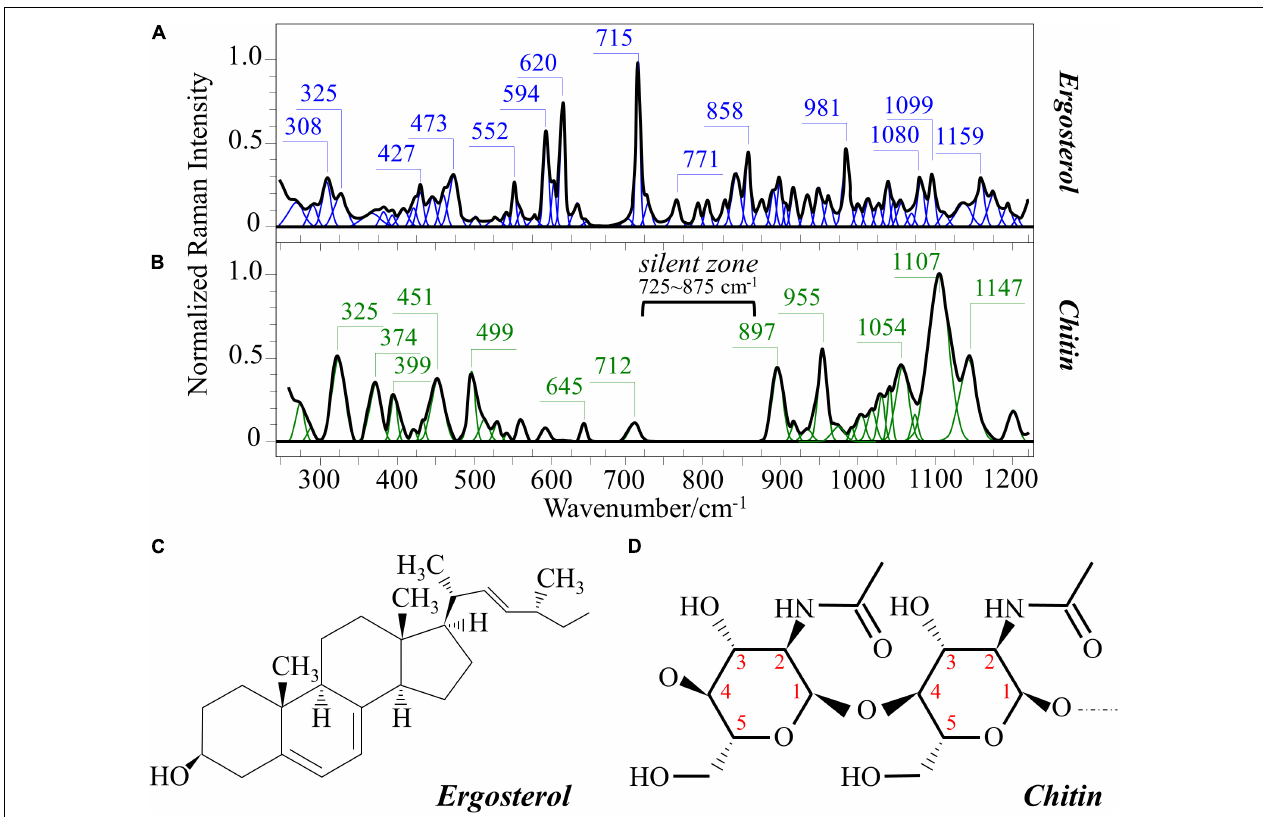
FIGURE 4 | Reference Raman spectra of: (A) ergosterol and (B) chitin (frequencies in cm - 1 of the main bands given in inset); (C,D) give the respective molecular structures (cf. labels in inset). The spectra are deconvoluted in series of Voigtian